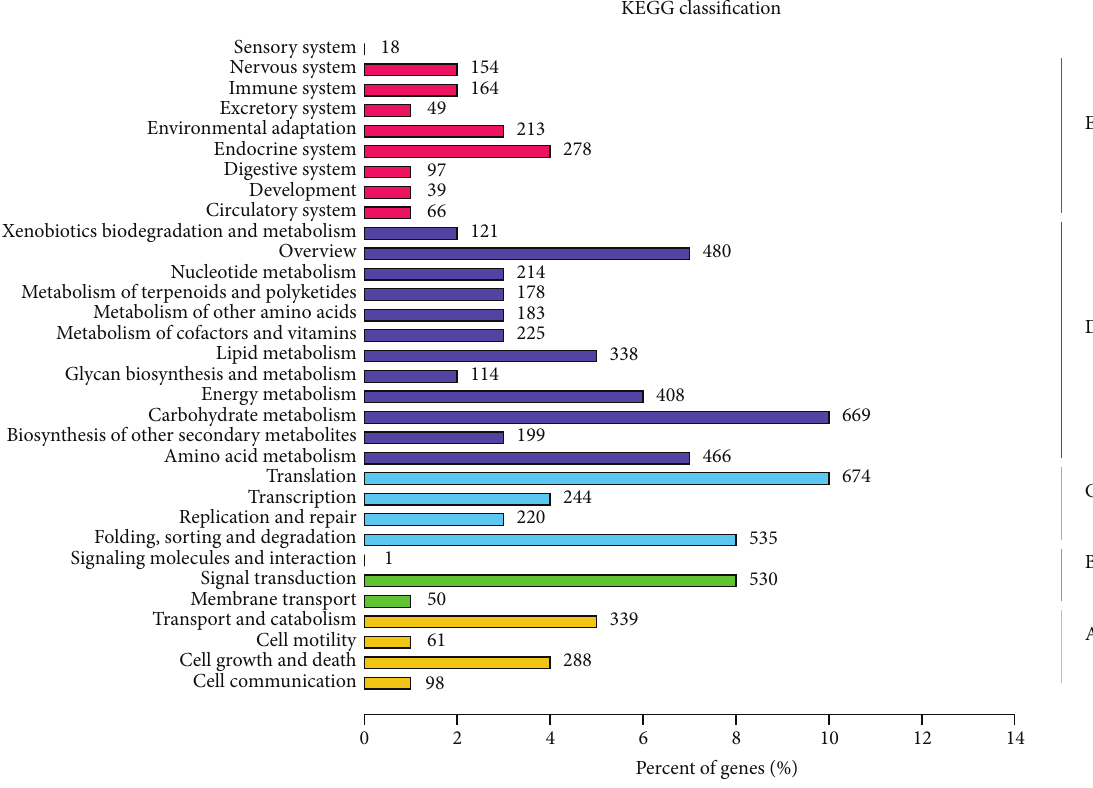
Figure 2: Pathway assignment based on KEGG. (A) Cellular processes; (B) environmental information processing; (C) genetic information processing; (D) metabolism; (E) organismal